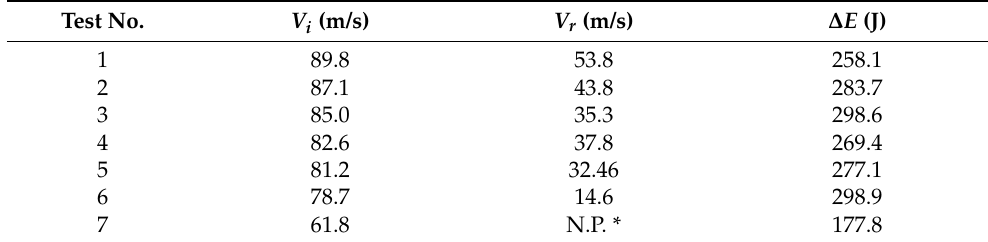
Table 3. Results of the ballistic test on 300 × 300 mm panels.